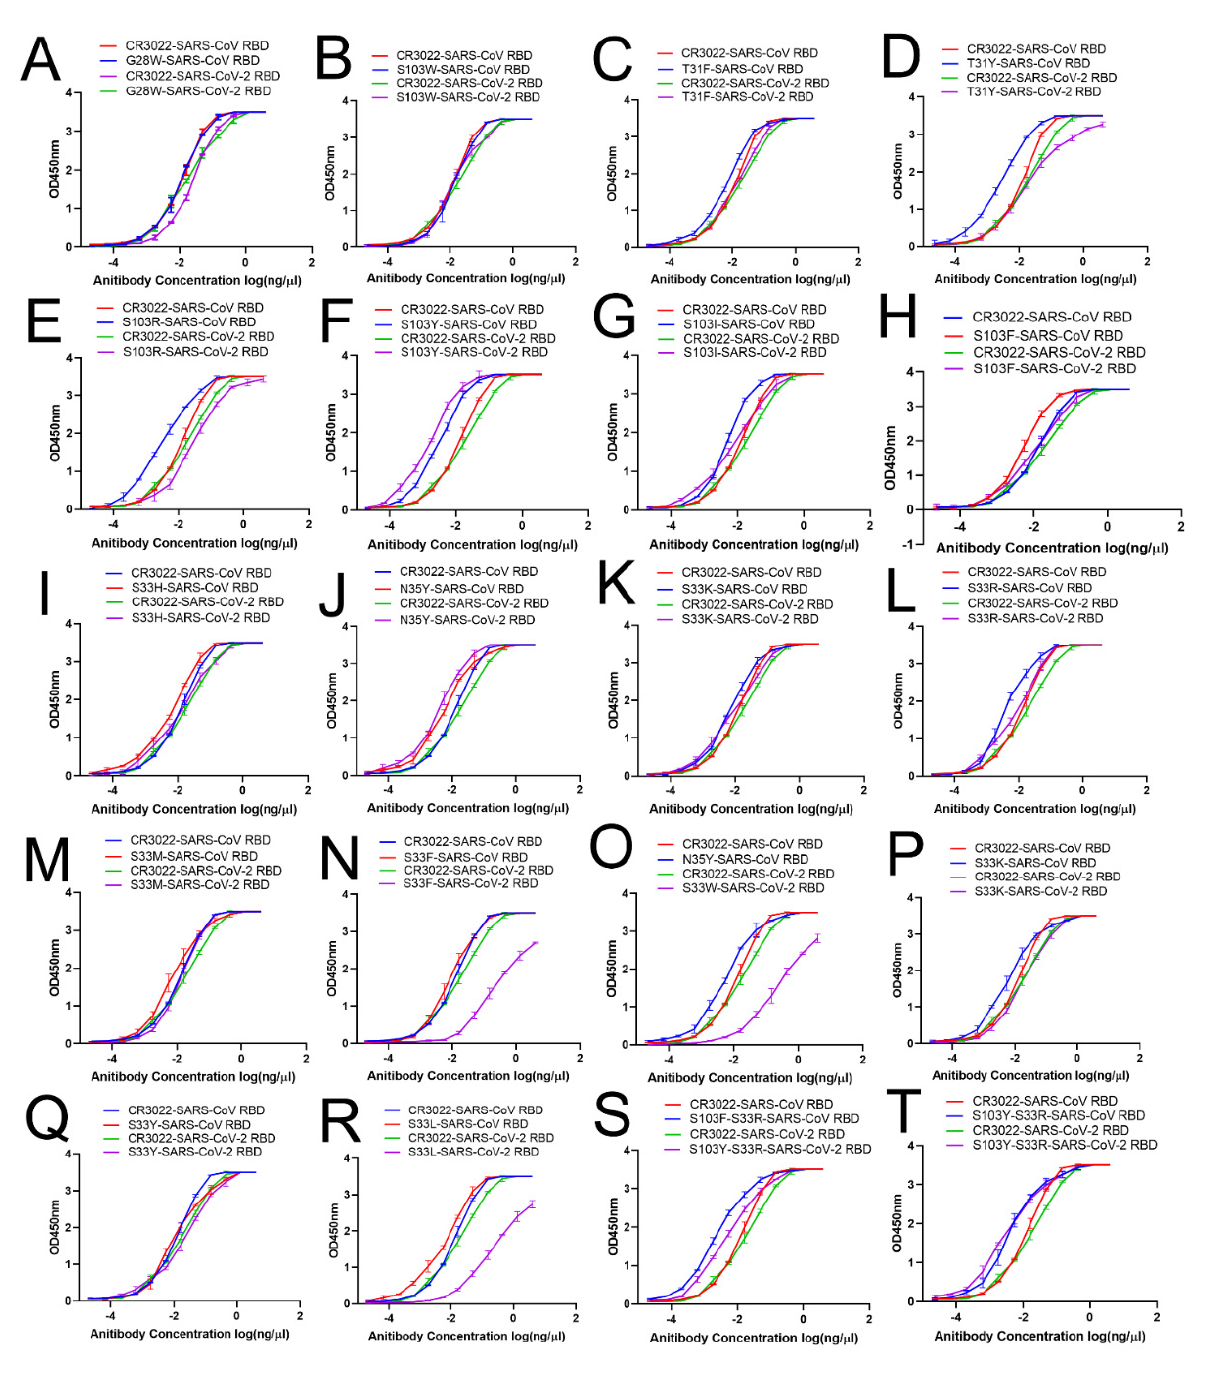
Figure 3. Analysis of the ability of 18 single-site mutants and two double-site mutated antibodies to bind SARS-CoV RBD and SARS-CoV-2 RBD with wild-type in ELISA. The ability of the wild-type and mutant antibodies as indicated in the individual binding curves were tested in 12-fold serial dilutions for binding to SARS-CoV RBD and SARS-CoV-2 RBD. The binding curves of ( A – T ) were single-site mutant of G28W, T31F, T31Y, S103R, S103I, S103F, S103W, S103Y, S33R, S33H, S33I, S33L, S33K, S33M, S33F, S33W, S33Y, N35Y and two double-site mutants of S103F(H)–S33R(L) and S103Y(H)–S33R(L), respectively.